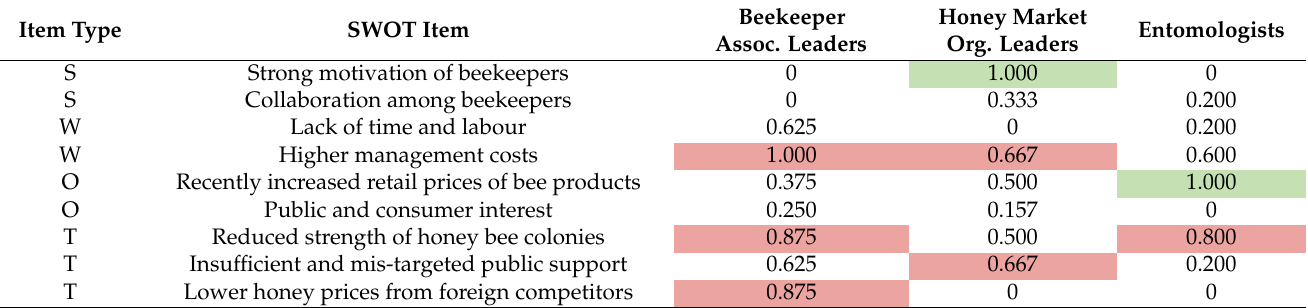
Table 3. Ranking of the mutual effects—sums of the absolute values of the scores per column (normalised values). Item